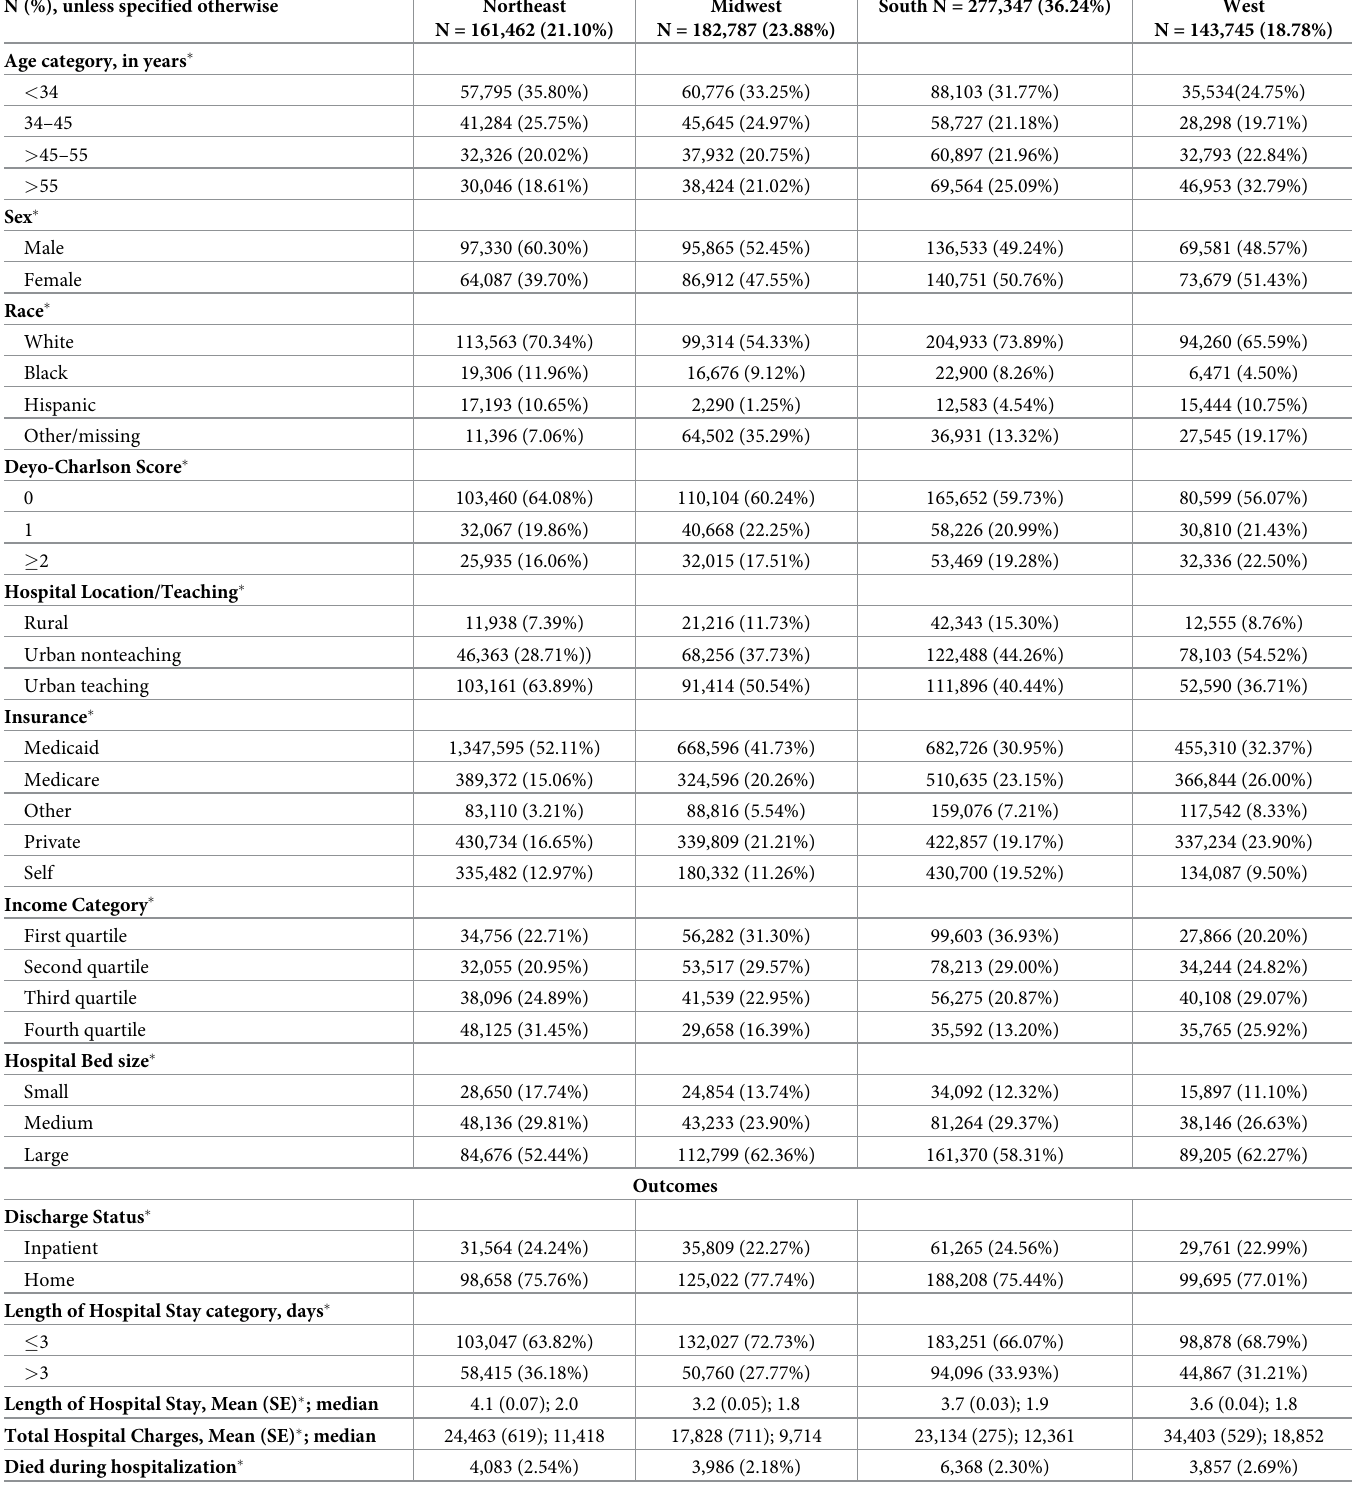
Table 2. OUD-hospitalization characteristics by U.S. hospital